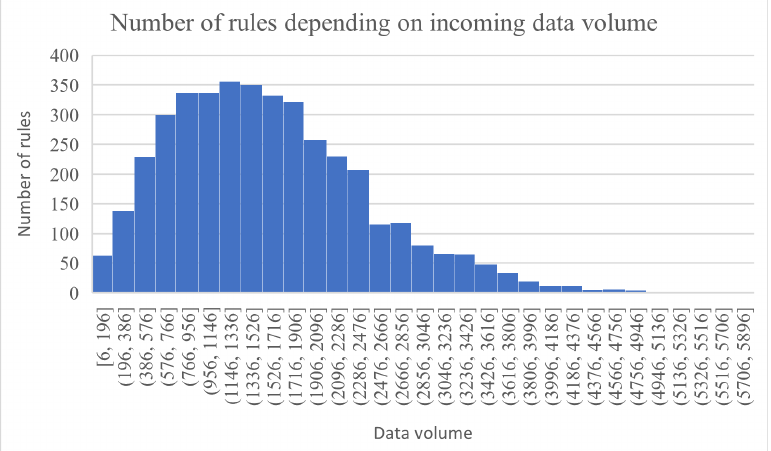
Figure 8. The number of rules whose incoming data from the sensors are in a specific